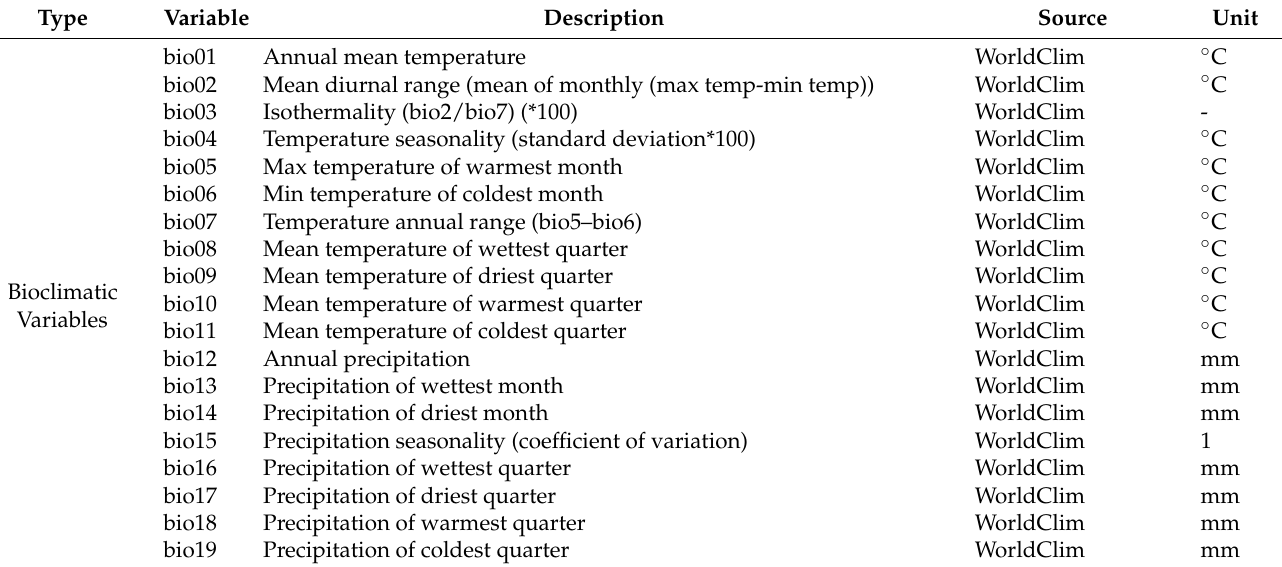
Table A1. Environmental variables for habitat suitability modeling of C. lanceolata